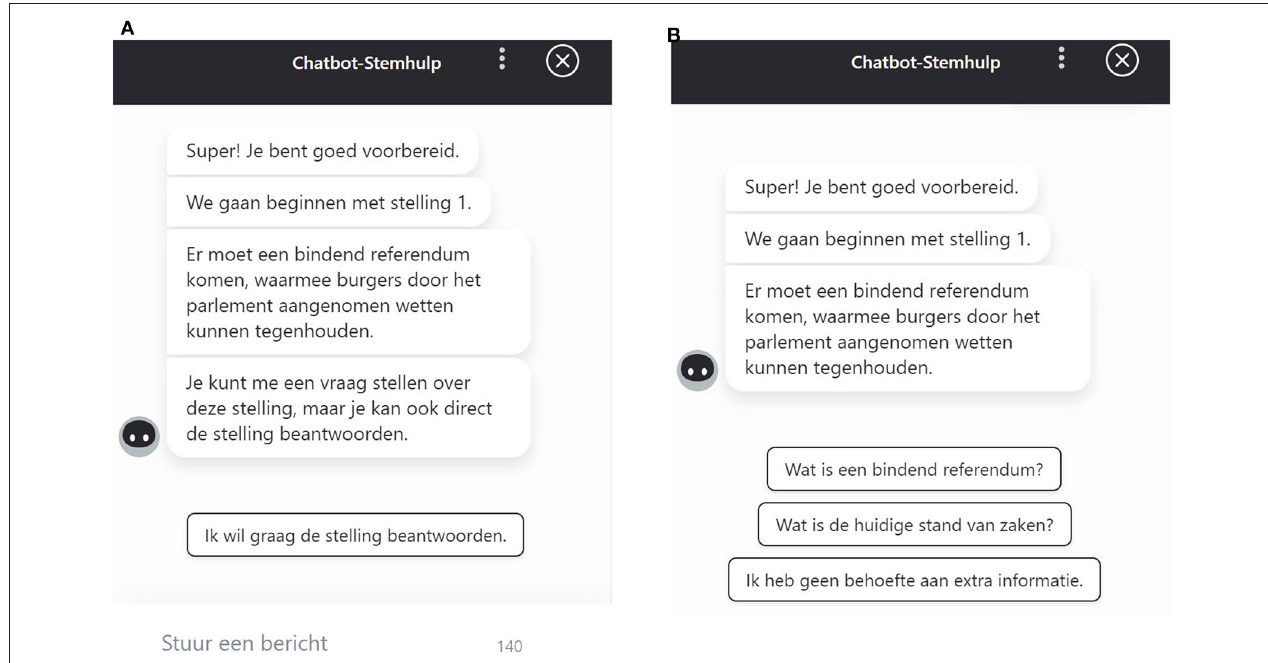
FIGURE 2 | (A) Example of the non-structured CAVAA design ( We will start with statement 1. There should be a binding referendum with which citizens can stop laws being implemented . You can ask me a question about this statement or directly respond to the statement ) showing a button to directly answer the question ( I want to answer the question ) and an open text field. (B) Example of the structured CAVAA design ( We will start with statement 1. There should be a binding referendum with which citizens can stop laws being implemented . You can ask me a question about this statement or directly respond to the statement ) with buttons that can be used for accessing additional information ( What is a binding referendum , What is the current state of affairs , and I do not need additional information ).